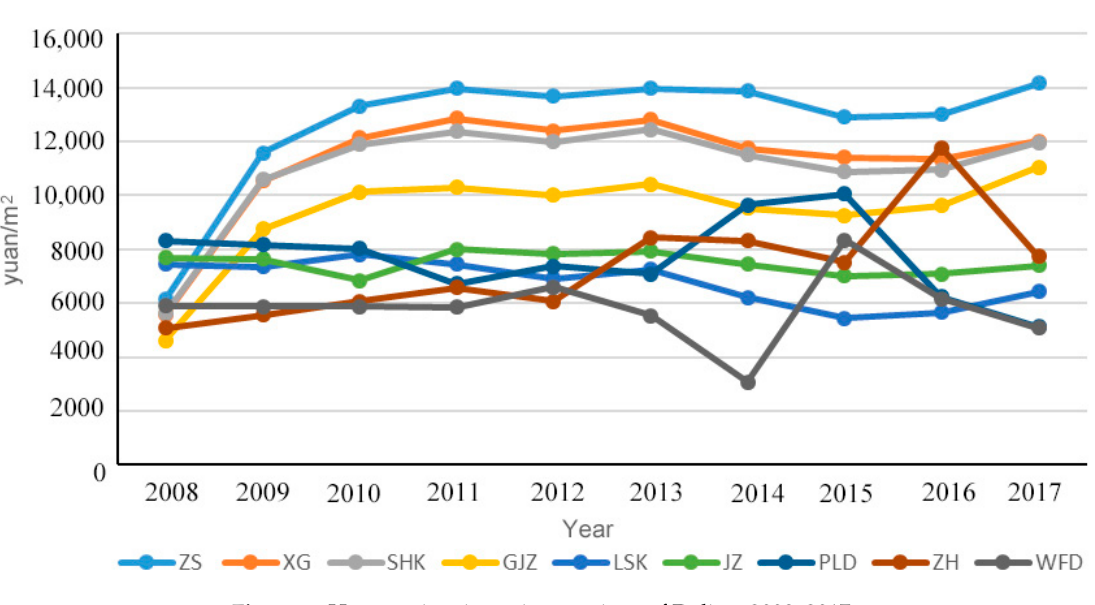
Figure 5. House prices in various regions of Dalian, 2008–2017.